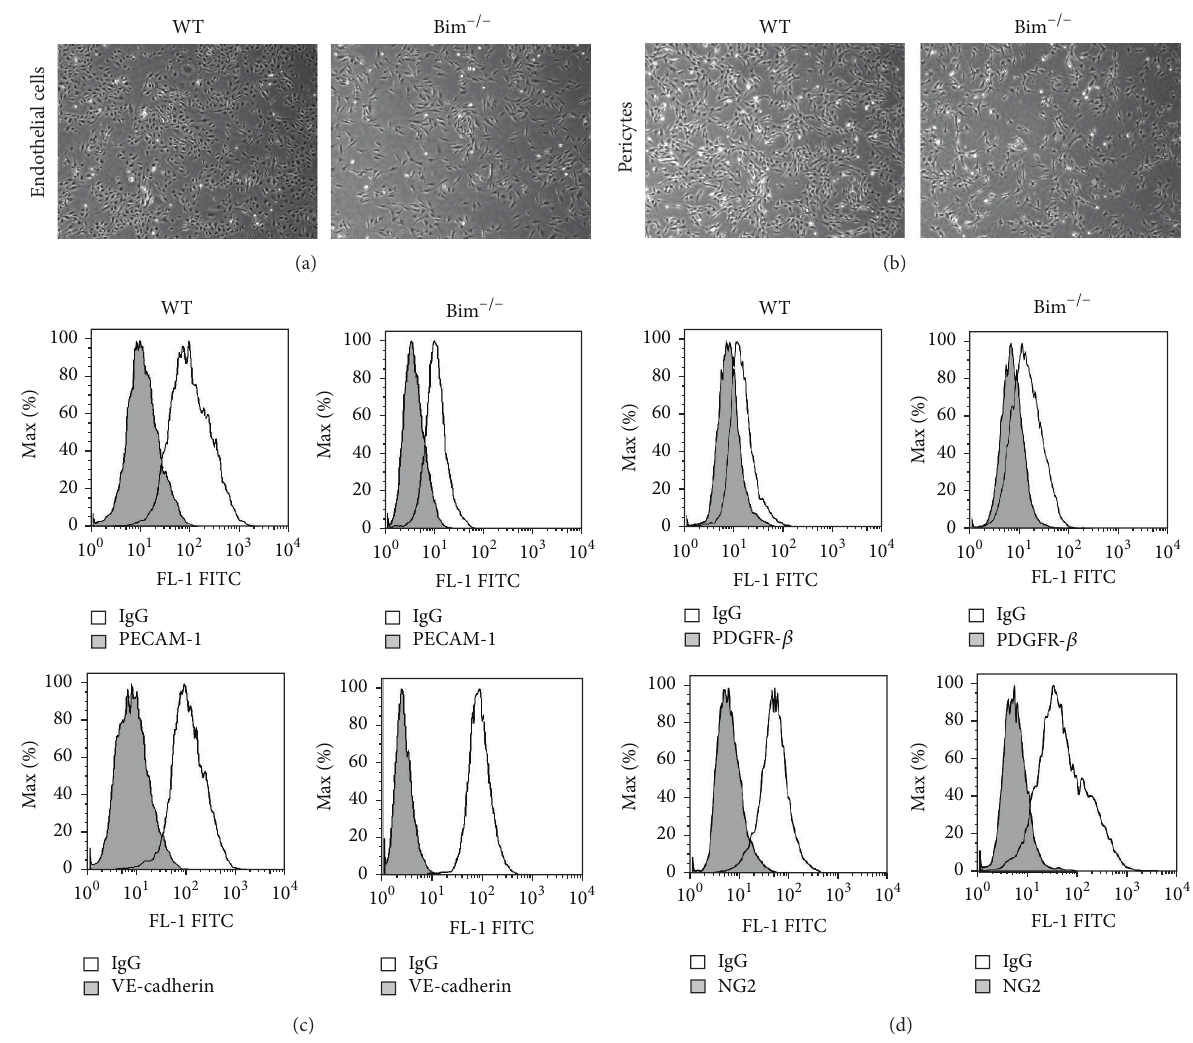
Figure 1: Wild-type and Bim −/− cells morphology. Wild-type and Bim −/− retinal endothelial cells (panel (a)) and pericytes (panel (b)) were cultured on gelatin or uncoated plates, respectively. Cells were photographed using a phase microscope in digital format at low magnification ( × 40). In panel (c), retinal endothelial cells prepared from wild-type and Bim −/− mice were examined for the expression of PECAM-1 and VE-cadherin FACScan analysis. In panel (d), retinal pericytes from wild-type and Bim −/− mice were examined for the expression of NG2 and PDGFR- 𝛽 by FACScan analysis. The shaded areas show staining in the presence of control IgG.